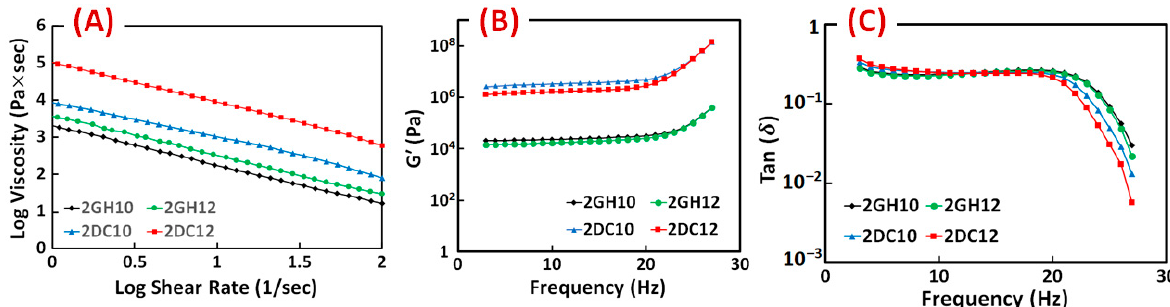
Figure 5. ( A ) Viscosity, ( B ) storage modulus (G ′ ) and ( C ) loss tangent (tan ( δ )) of GH and DC hydrogels composed of different macromere concentrations and guest macromere ratios.